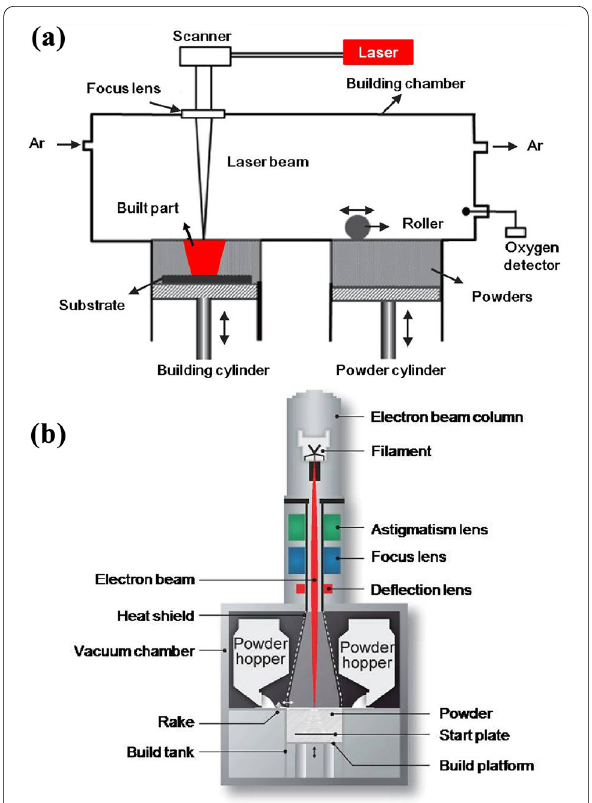
Figure 16 Schematic diagram of SLM process [71] and EBM process